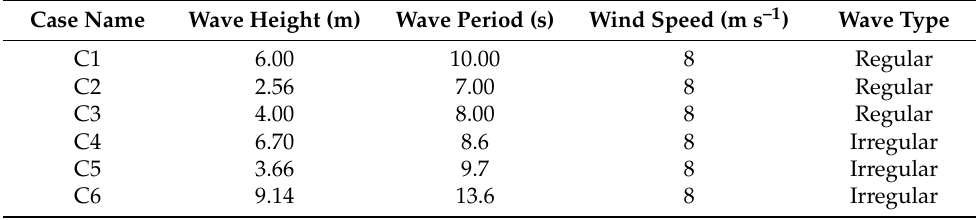
Table 2. Environmental condition